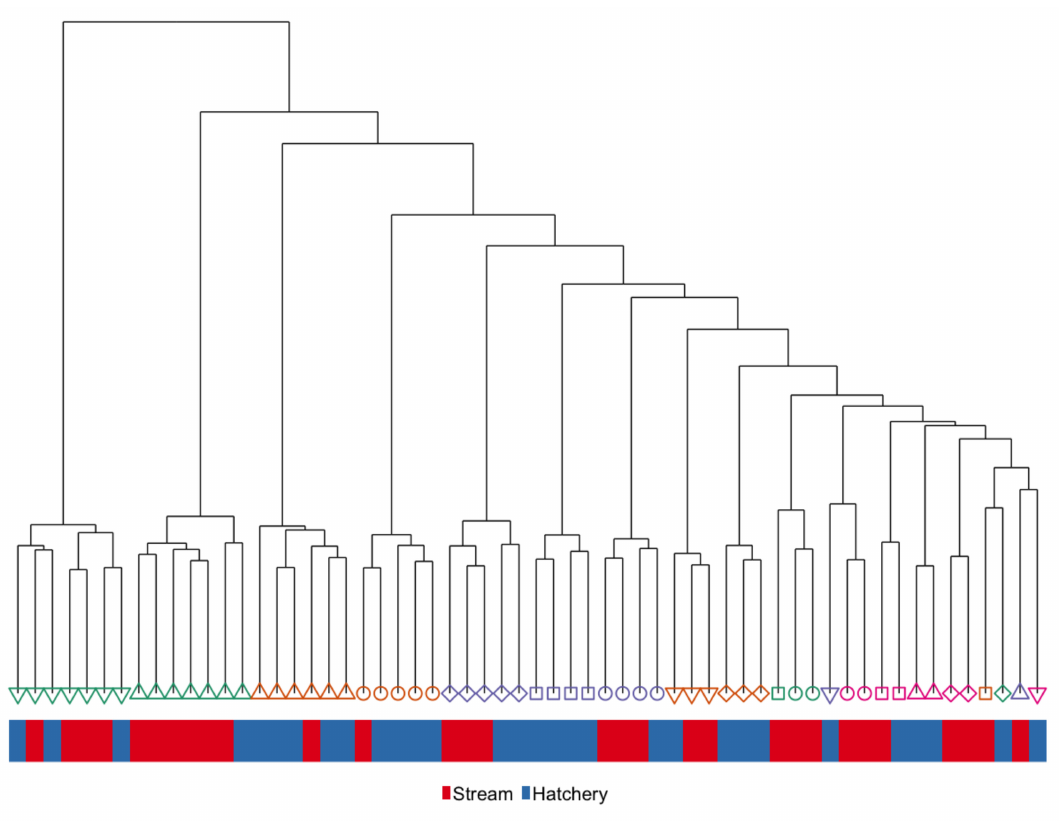
Figure 8. Hierarchical clustering of global DNA methylation patterns in the Intergenerational sample set. Color of the bar represents rearing treatment and color / shape represents